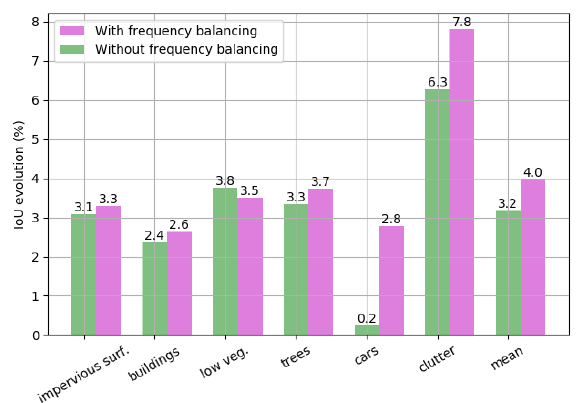
Figure 5. Study of the impact of the frequency balancing during training on the Potsdam validation set.